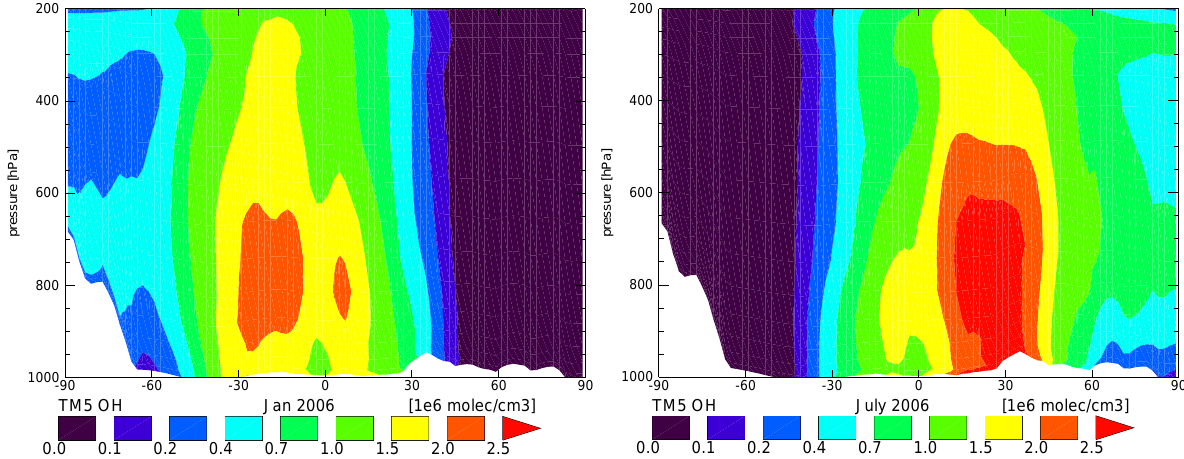
Fig. 2. Zonal monthly mean OH concentrations for January and July 2006 as simulated by the TM5 model. Spivakovsky OH field was optimized, resulting in a scaling factor of 0.92 and a MCF lifetime of 5.76 yr, i.e. ∼ 2% lower than in the current TM5